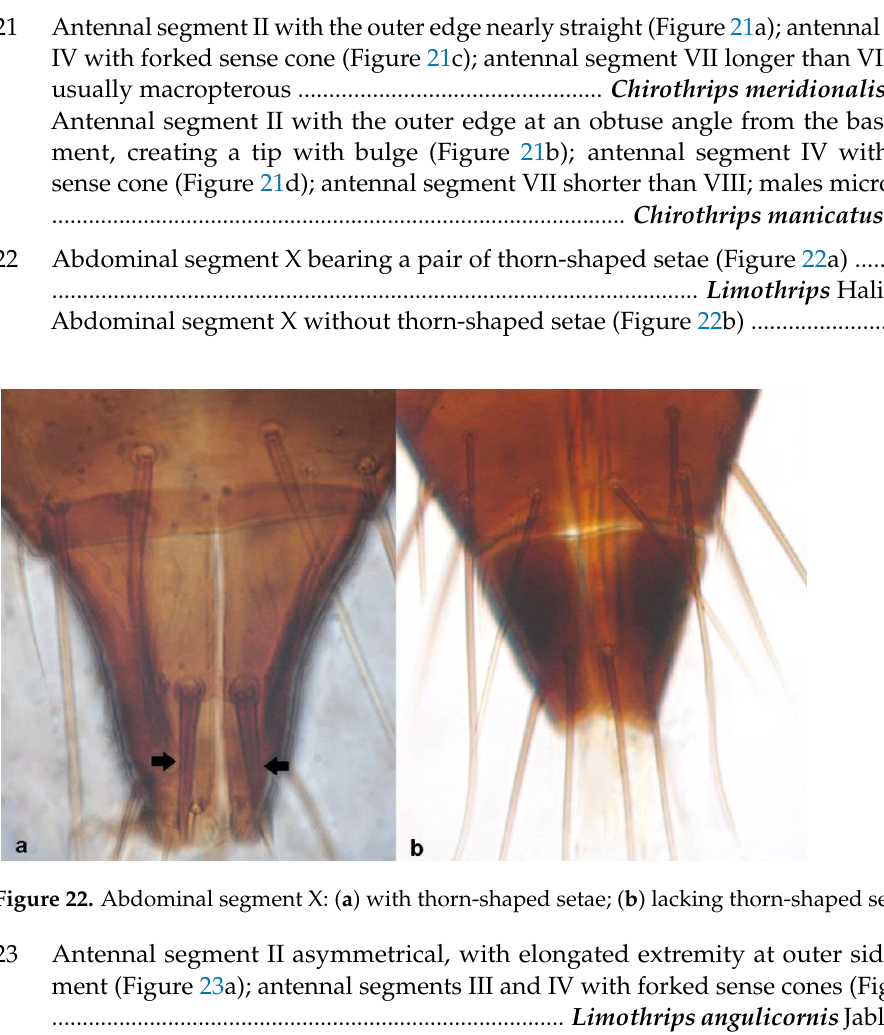
Figure 22. Abdominal segment X: ( a ) with thorn-shaped setae; ( b ) lacking thorn-shaped setae. 23 Antennal segment II asymmetrical, with elongated extremity at outer side of segment (Figure 23a); antennal segments III and IV with forked sense cones (Figure 23c) Antennal segment II rounded and symmetrical (Figure 23b); segments III and IV with simple sense cones (Figure 23d) ....................................... Limothrips cerealium